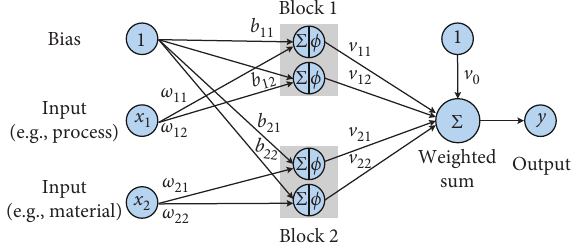
Figure 8: Graphical representation of a blocked neural network with two neurons per block. In this sketch, only two inputs are visualized, while the blocked neural network in this study has five inputs (two process and three material